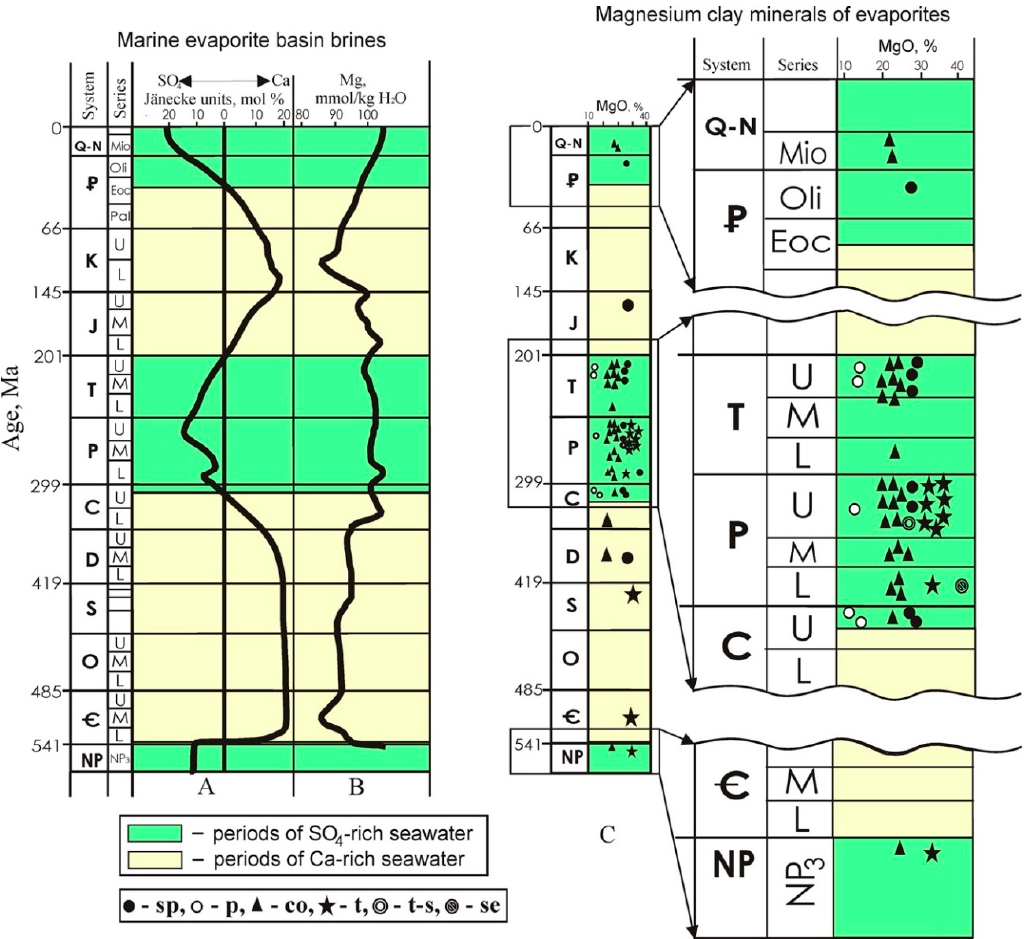
Figure 6. The correlation between secular variations in seawater chemistry ( A , modified from [116]), Mg content in seawater ( B , modified from [13]), and occurrence of Mg-rich clay minerals ( C , modified from [108]); co—corrensite, p—palygorskite, se—serpentine, sp—sepiolite, t—talc, t-s—talc-smectite.